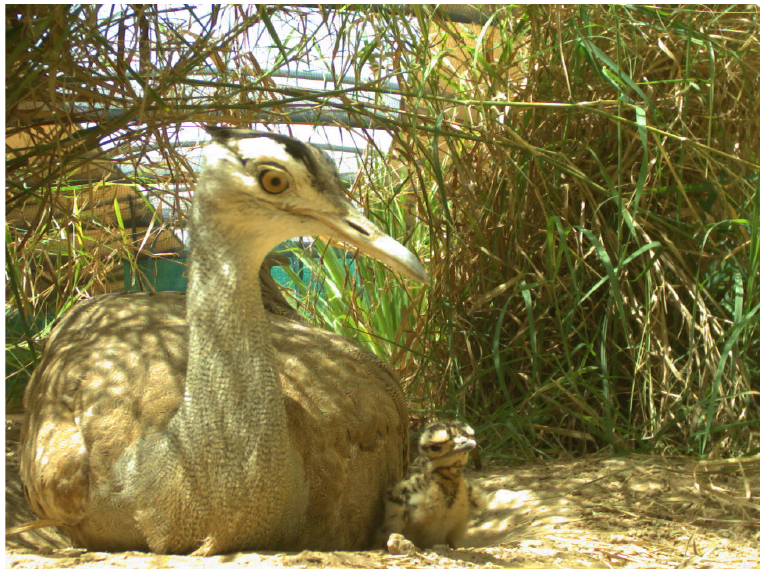
Figure A1. Captive female Arabian bustard turning eggs at the nest.